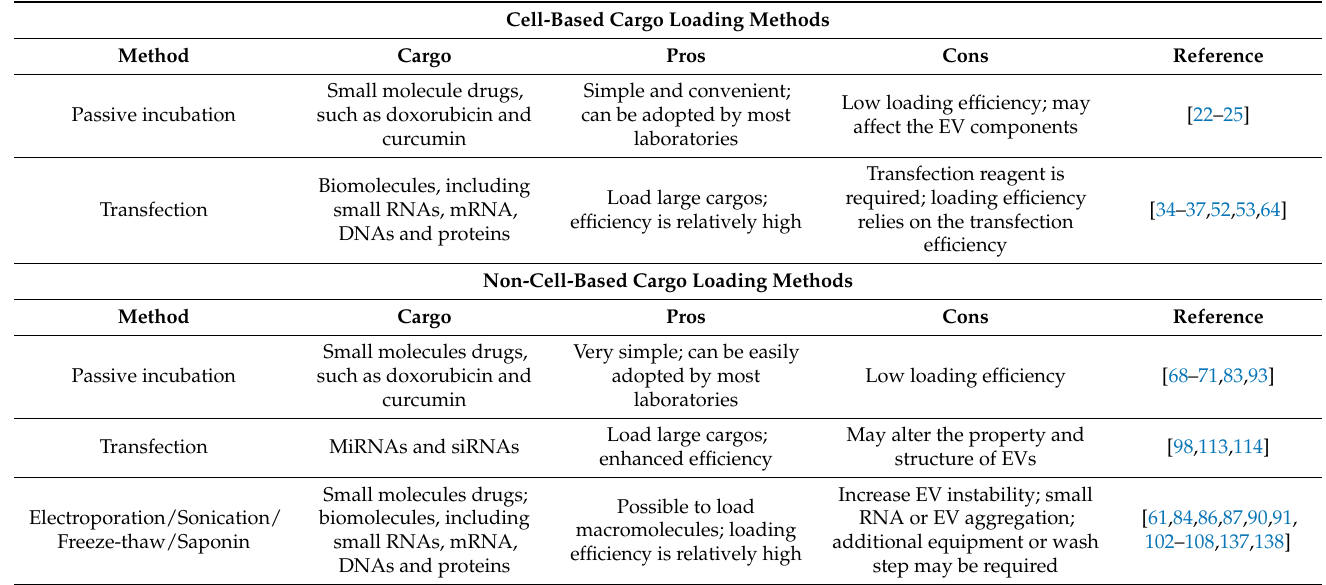
Table 1. Comparison of cargo loading